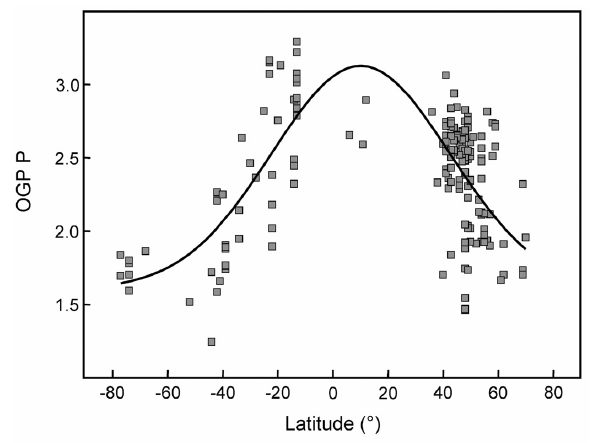
F IG . 3. – Relationship of overall growth performance ( P = log K + log M ) and latitude of 198 populations of 26 scallop species (for ∞ references see Heilmayer 2003). Regression line: